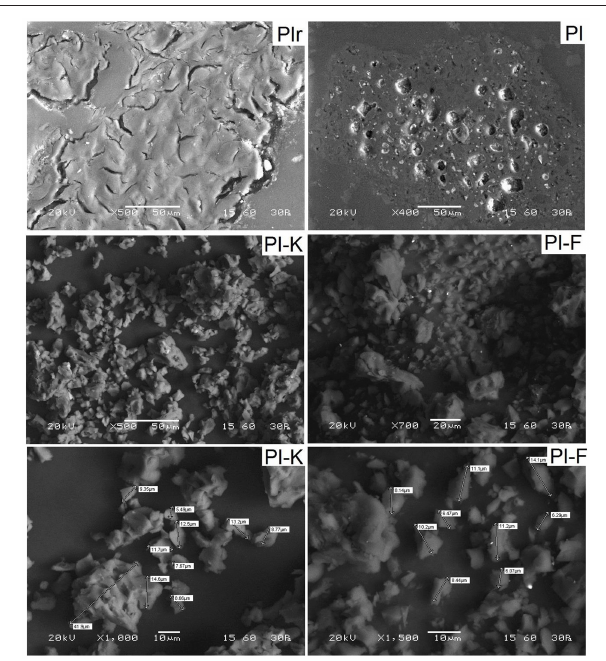
FIGURE 2 | SEM images of raw pistachio shells (PIr) and biochars PI, PI-K (x500, x1000), and PI-F (x700, x1500).